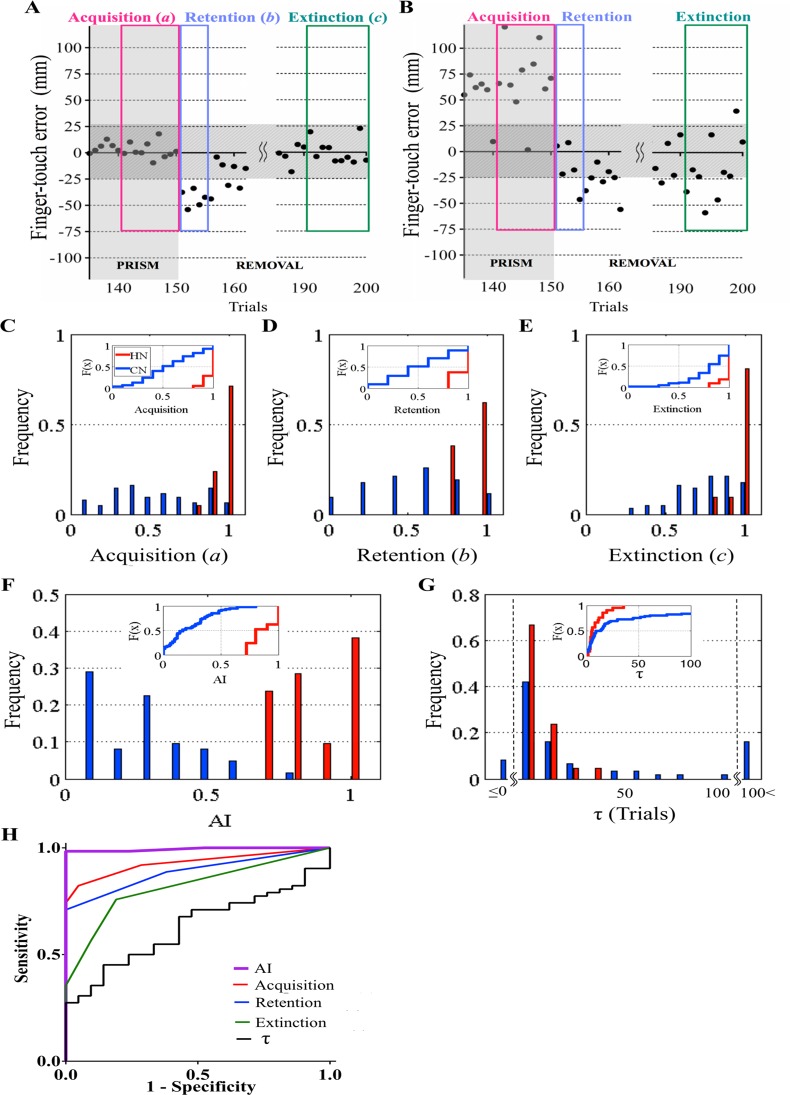
Quantitative evaluation of prism adaptation.(A) An example of adaptation in a healthy subject (HN13) shown in Fig. 2A. The finger-touch error of the last 10 trials of PRISM, and that of the initial five and last 10 trials of REMOVAL are extracted from Fig. 2A. Acquisition, retention, and extinction of adaptation were estimated from the probability of success (a) in the last 10 trials of PRISM (10/10), the probability of failure (b) in the initial five trials of REMOVAL (5/5), and the probability of success (c) in the last 10 trials of REMOVAL (10/10), respectively. AI was calculated as a × b × c and 1 in this case. (B) Similar analysis in CN4 shown in Fig. 2B. a = 1/10, b = 1/5, c = 6/10. AI = (1/10) × (1/5) × (6/10) = 0.012. Horizontally shaded areas in (A) and (B) represent the zone of “correct” touch (within ± 25mm). (C)–(F) Frequency distributions of a (C), b (D), c (E), and AI (F). Insets represent cumulative frequency curves. F(x) represents normal cumulative distribution function. (G) Frequency distribution of the time constant τ (for details, see Materials and Methods). Insets represent cumulative frequency curves of τ. Red columns and lines in (C)–(G) show data for 21 HN subjects. Blue columns and lines in (C)–(G) show data for 62 CN patients. (H) Receiver operating characteristic (ROC) curve analysis in the HN and CN groups. A purple line shows ROC curve for AI, a red line for the probability of acquisition, a blue line for the probability of retention, a green line for the probability of extinction, and a black line for τ.